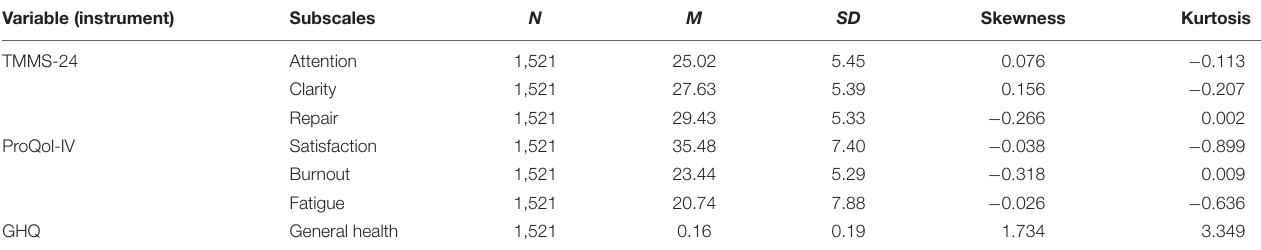
Correlation analysis ( Table 2 ) showed positive associations between the three dimensions of the emotional intelligence scale, negative correlations for satisfaction in relation to burnout and fatigue, while satisfaction maintained a positive relationship with the variables of clarity and repair. Overall health showed a positive relationship with attention, burnout and fatigue and a negative correlation with clarity and repair. TABLE 1 | Descriptive statistics for the total number of participants. Variable (instrument)